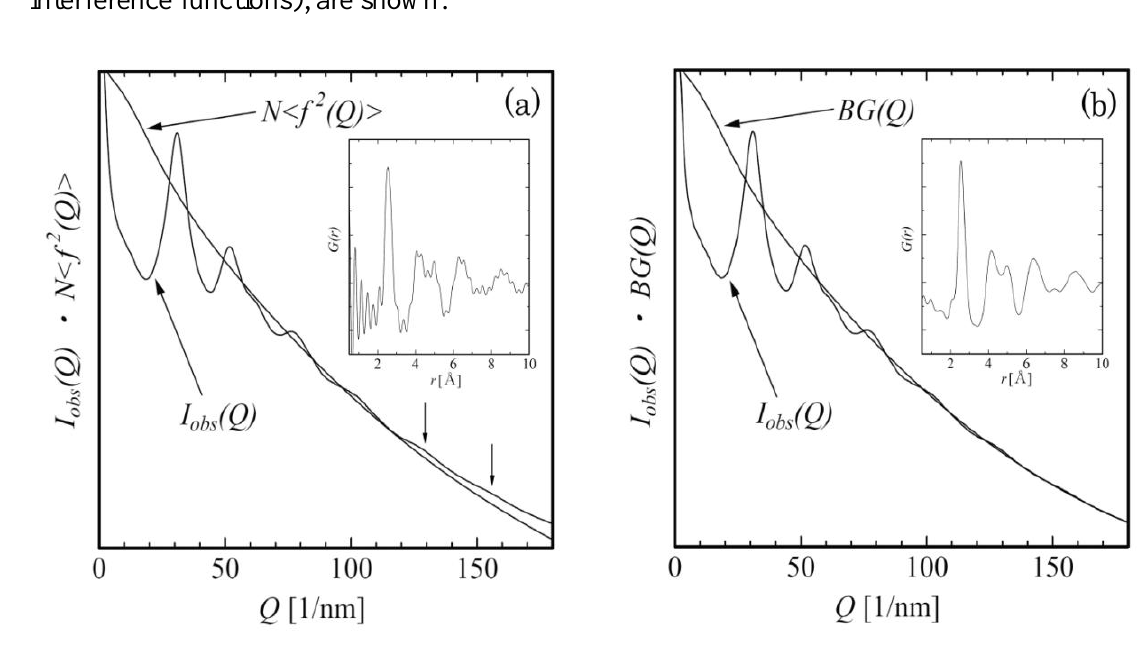
Figure 1. ( a ) Background profile proportional to atomic scattering factor and ( b ) slightly modified background profile, together with the electron diffraction intensity obtained from an Fe B metallic glass. In each inset, reduced pair distribution functions, which are 80 20 derived by Fourier transform of background-subtracted intensity profiles (reduced interference functions), are